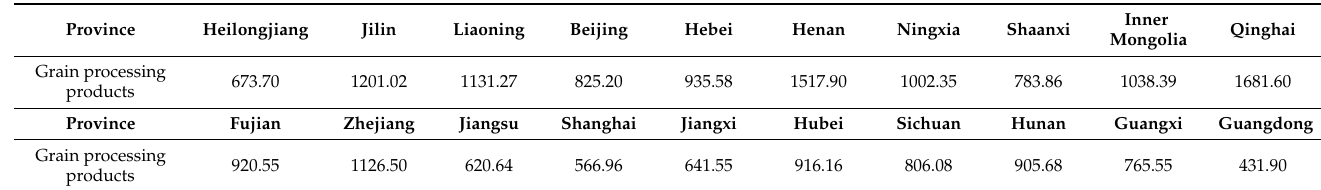
Table 2. Grain processing product consumption (g/day) of